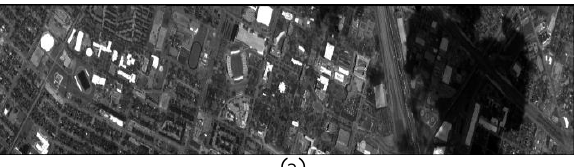
Figure 4. 8 texture features obtained from GLCM matrix a) Mean, b) Variance, c) Homogeneity, d) Second Moment,